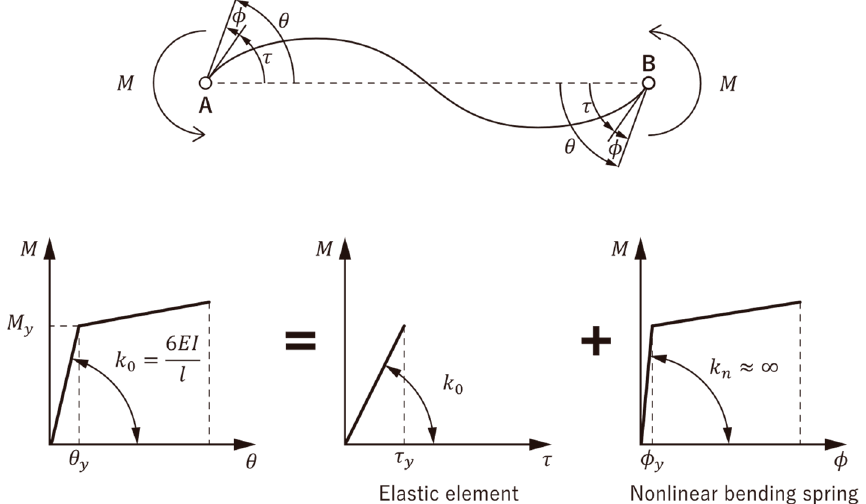
Figure 20. Moment-rotation relationship for bending spring.